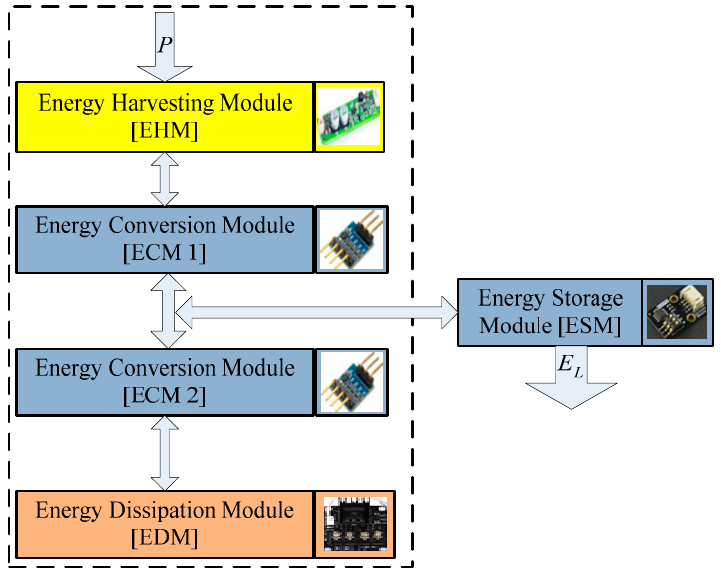
Figure 12. Block diagram of autonomous hybrid electromagnetic energy harvesting system [75].